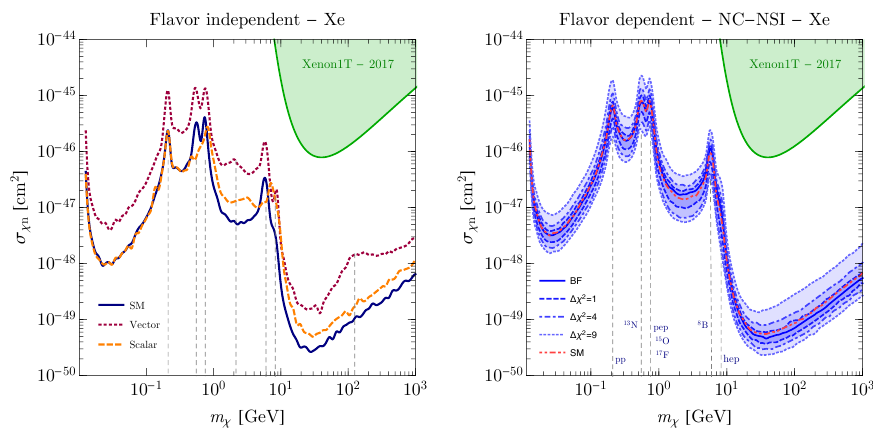
Figure 5.2: Neutrino discovery limit for a Xe experiment considering the presence of new physics, flavor dependent scenarios (left) and NC-NSI (right).